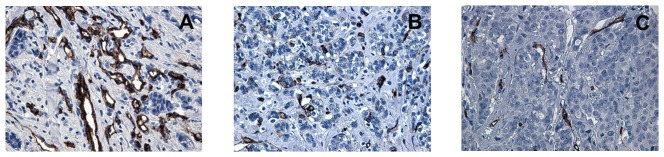
Microvessel density in representative tissue samples of breast cancer.(A) and (B) show high MVD in BRCA1-2 carrier and BRCAX breast cancers respectively; (C) shows low MVD in sporadic breast cancers.